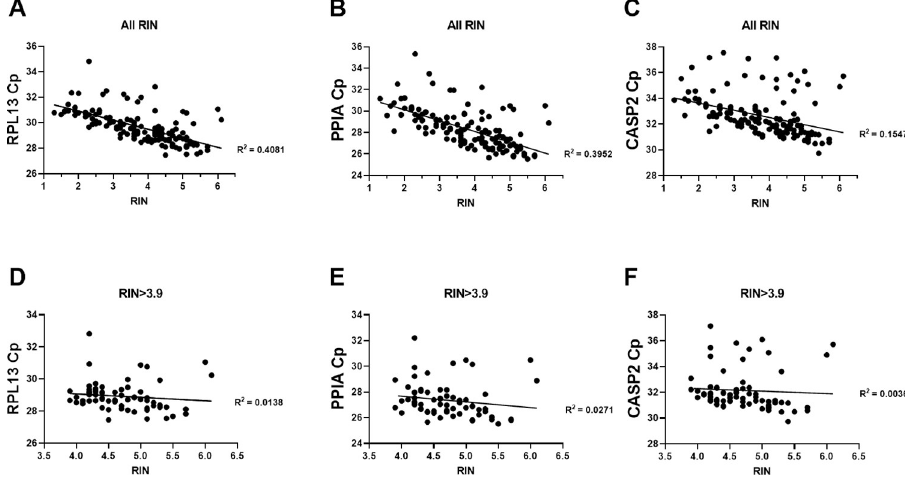
Fig 1. RT-qPCR crossing points correlate with RNA integrity numbers. Crossing point (Cp) values for housekeeping genes RPL13 (A) and PPIA (B), and caspase-2L (C) are significantly correlated with RIN number. RPL13 (D), PPIA (E) and caspase-2L (F) Cp-values after a cutoff of RIN � 3.9 no longer show a significant negative correlation.